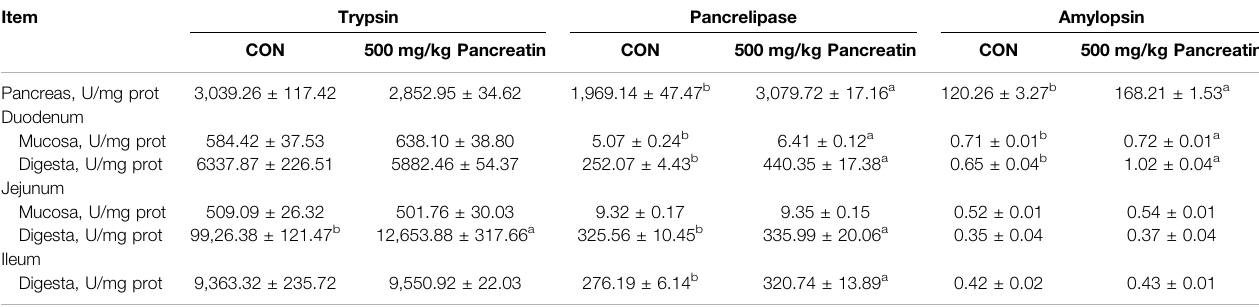
TABLE 5 | Effect of pancreatin on trypsin, pancrelipase, and amylopsin activity in piglets.